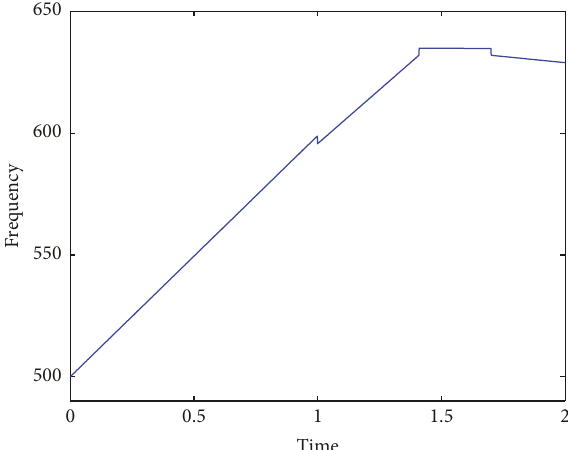
Figure 10: Estimated instantaneous frequency of the signal pre- sented in Figure 13.